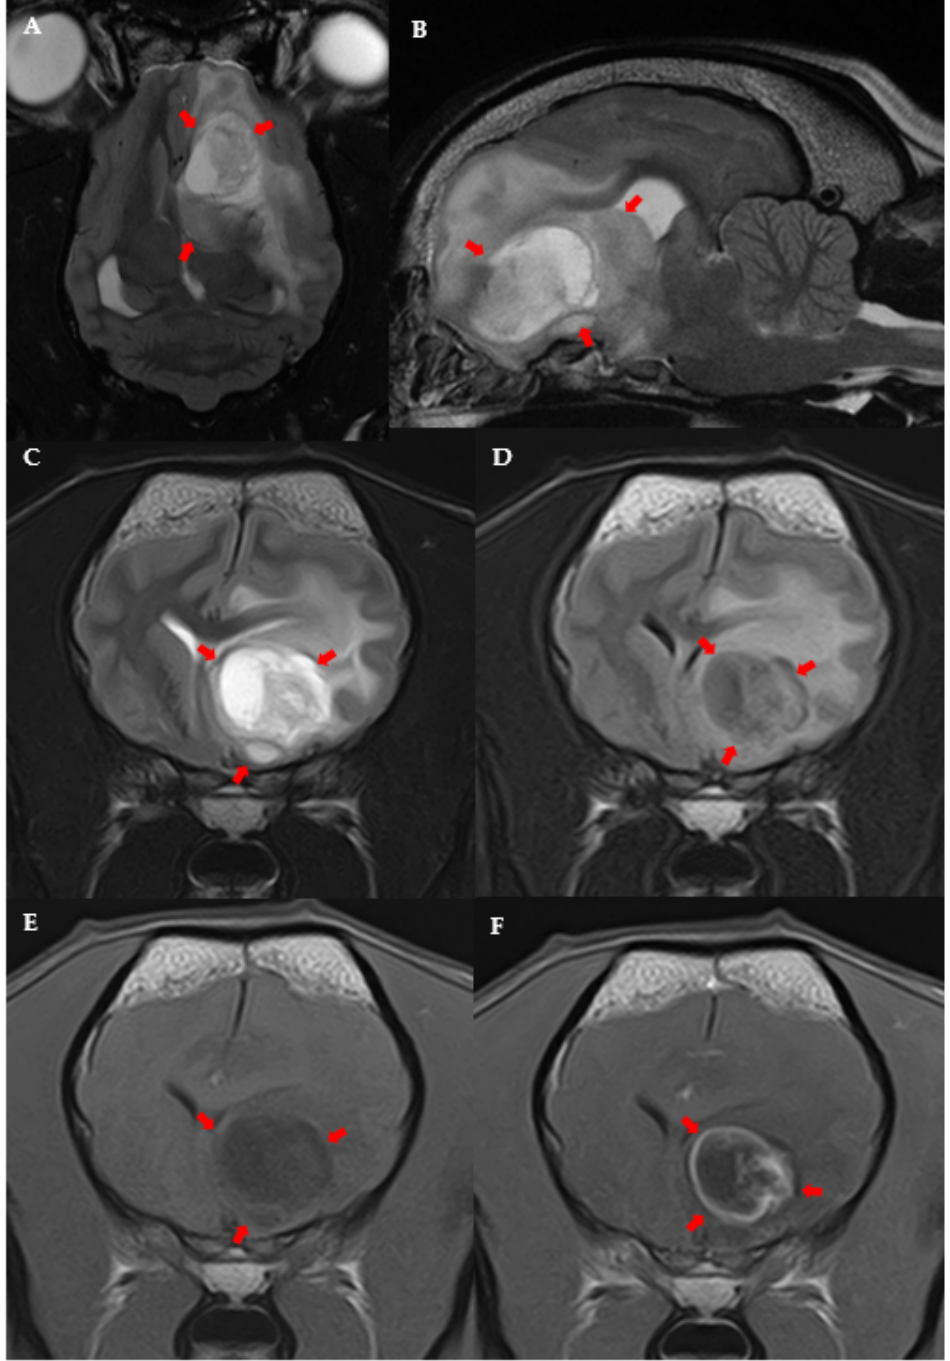
Figure 3. MRI images of suspected high-grade glioma in the left fronto-olfactory cortex in an 8-year- old female French Bulldog: Dorsal ( A ) and left parasagittal ( B ), T2-w. Transverse T2-w ( C ), T2-FLAIR ( D ), T1-w ( E ), and T1 post-contrast ( F ). The left side of the patient is on the right side of the image. Arrows point to the lesion.